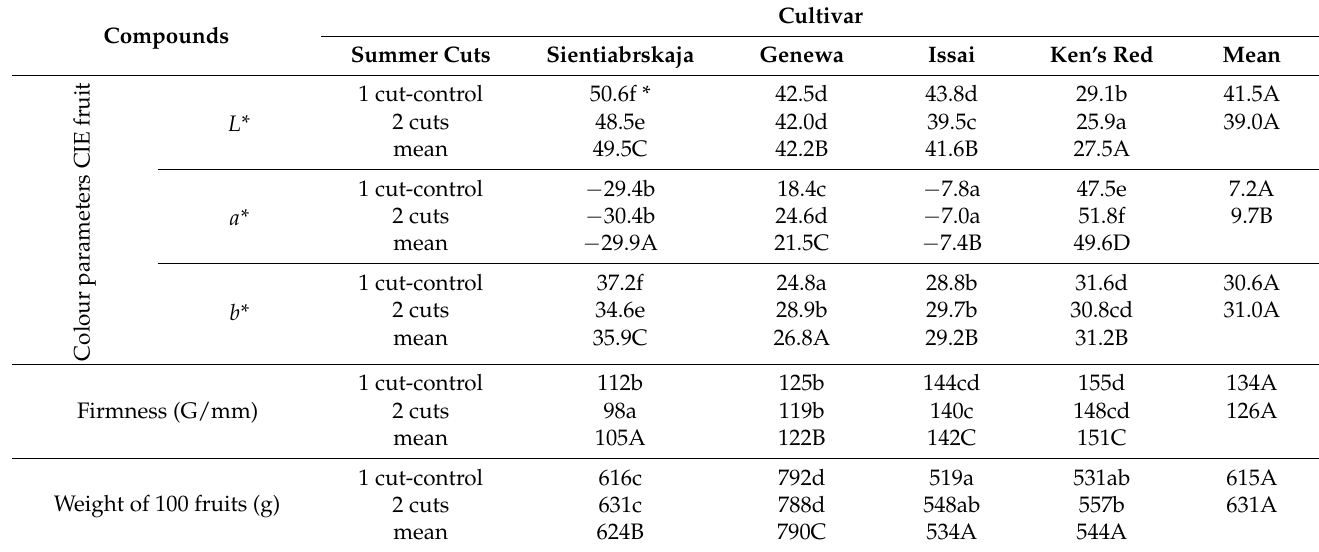
Table 4. Color of fruits and the quality of Actinidia